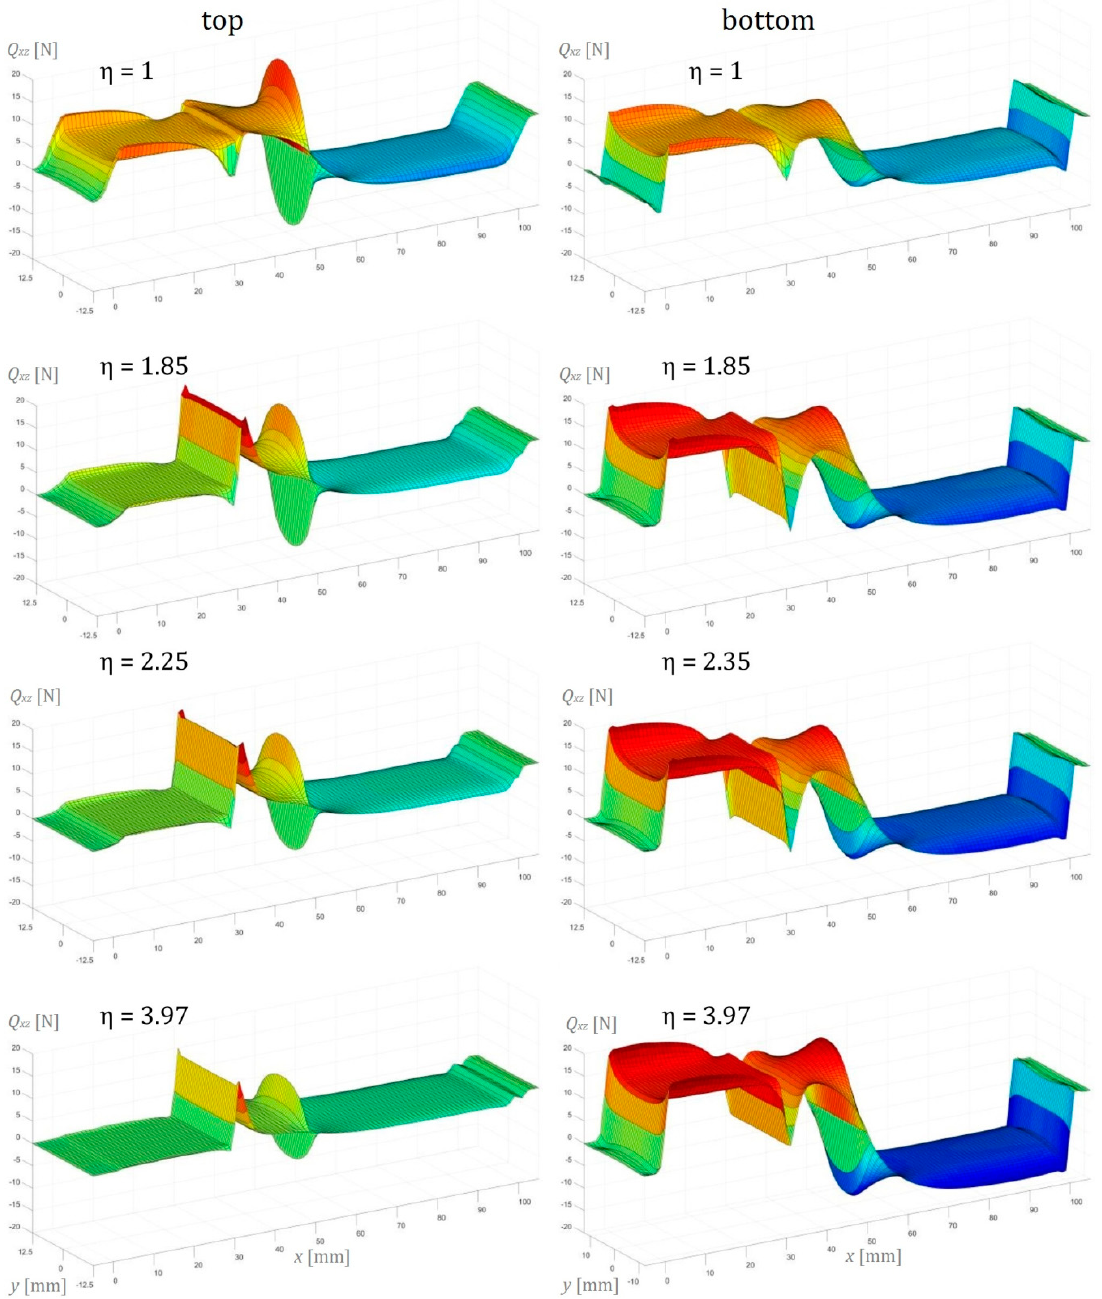
Figure 16. Transverse shear force per unit width Q xz in the longitudinal direction of the AENF.